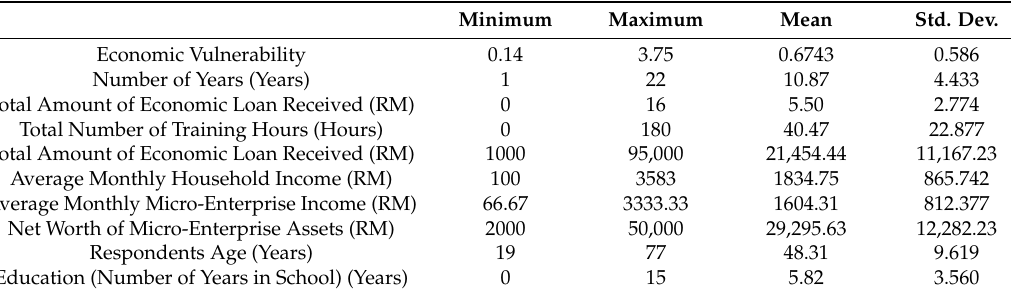
Table 2. The respondents and participation